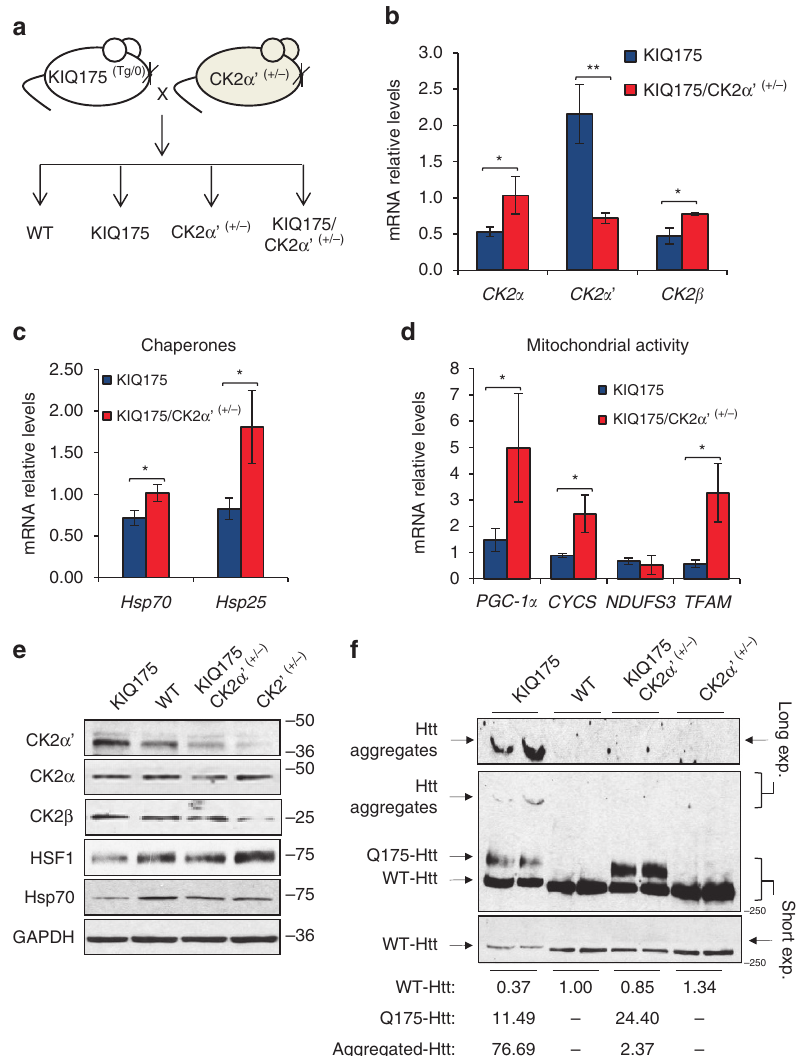
Figure 7 | CK2 a 0 heterozygosity increases HSF1 abundance and activity in HD mice. ( a ) Mouse breeding scheme to generate WT, KIQ175, CK2 a 0 þ / (cid:2) and KIQ175/CK2 a 0 þ / (cid:2) mice. ( b ) CK2 a , CK2 a 0 and CK2 b mRNA levels from KIQ175 and KIQ175/CK2 a 0 þ / (cid:2) striatum at 6 months. Data was normalized to GAPDH and referenced to WT. ( c ) Chaperones Hsp70 and Hsp25 and ( d ) Mitochondrial activity-related genes PGC-1 a , CYCS, NDUFS3 and TFAM mRNA levels from the striatum of KIQ175 and KIQ175/CK2 a 0 þ / (cid:2) at 6 months. ( e ) Immunoblots of striatum from KIQ175, WT, KIQ175/CK2 a 0 þ / (cid:2) and CK2 a 0 þ / (cid:2) at 6 months. ( f ) WT and mutant Htt immunoblot analysis from striatum of KIQ175, WT, KIQ175/CK2 a 0 þ / (cid:2) and CK2 a 0 þ / (cid:2) at 6 months. Long and Short exposures are presented. mRNA data shows fold change compared to the control group (WT; Supplementary Fig. 6) which values were set as 1. Error bars represent mean ± s.e.m., ( n ¼ 3 animals). Unpaired t -test * P o 0.05, ** P o 0.05. Values for the KIQ175/CK2 a 0 ( þ / (cid:2) ) group were compared to the KIQ175 group. See Supplementary Fig. 12 for uncropped